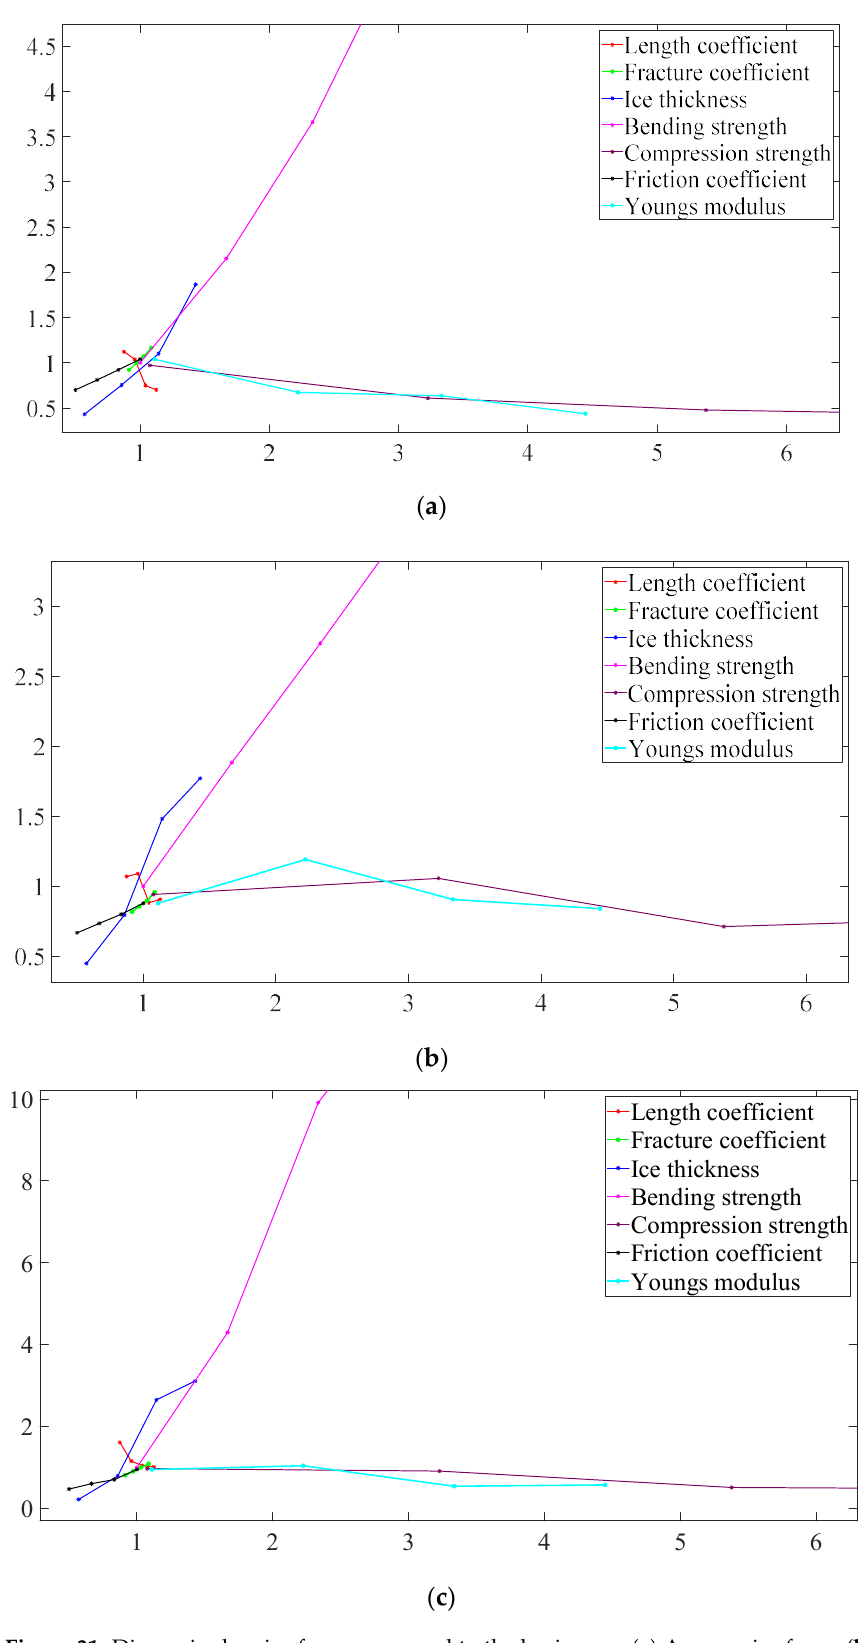
Figure 31. Dimensionless ice force compared to the basic case. ( a ) Average ice force; ( b ) Maximum ice force; ( c ) Variance.